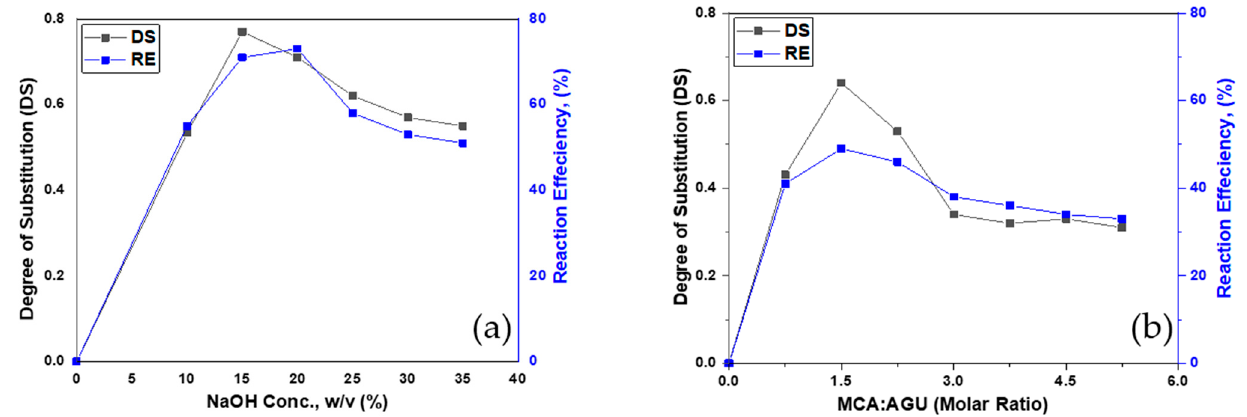
Figure 1. Effect of ( a ) NaOH concentration and ( b ) MCA molar ratio on DS and RE of CMTS.